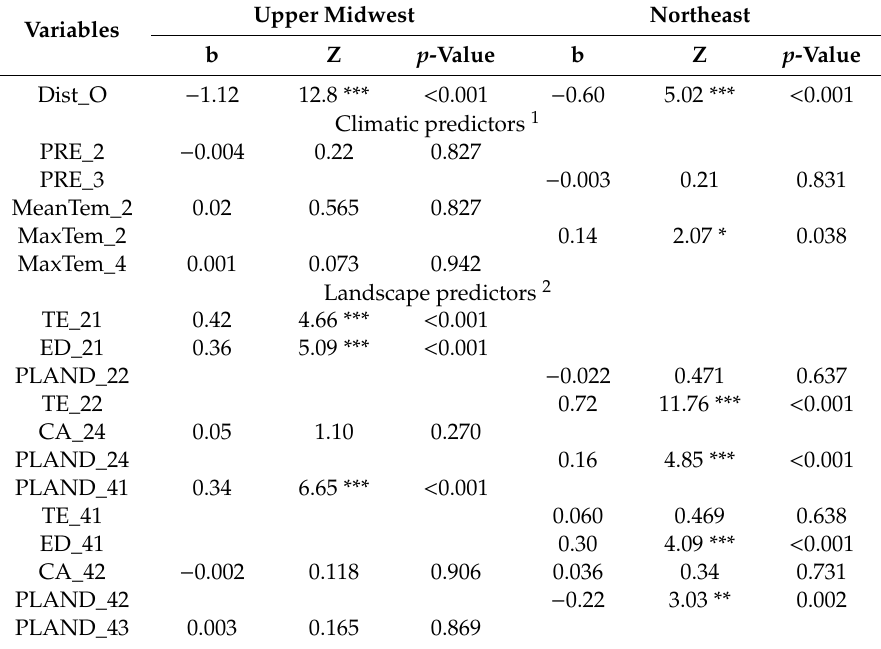
Table 3. Summary statistics (averaged regression coe ffi cient, b, Z-statistics, and p-values) for the predictors correlated with the Lyme cases in model averaging in the Northeast and Upper Midwest United Sates. For explanation of the variables, see Table